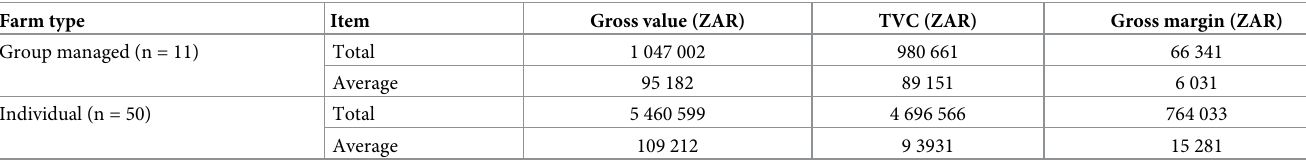
Table 1. Gross margin estimates (n =